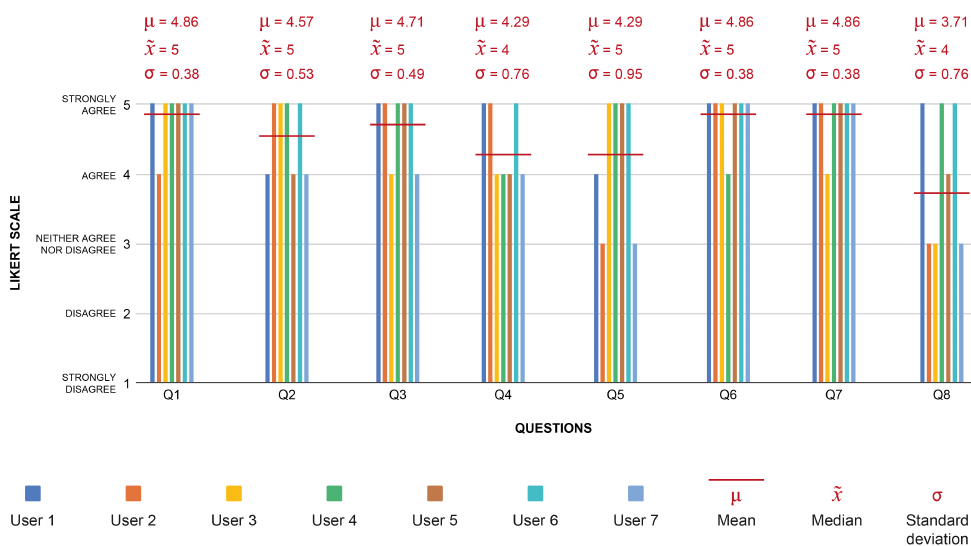
Figure 17. Questionnaire results for case